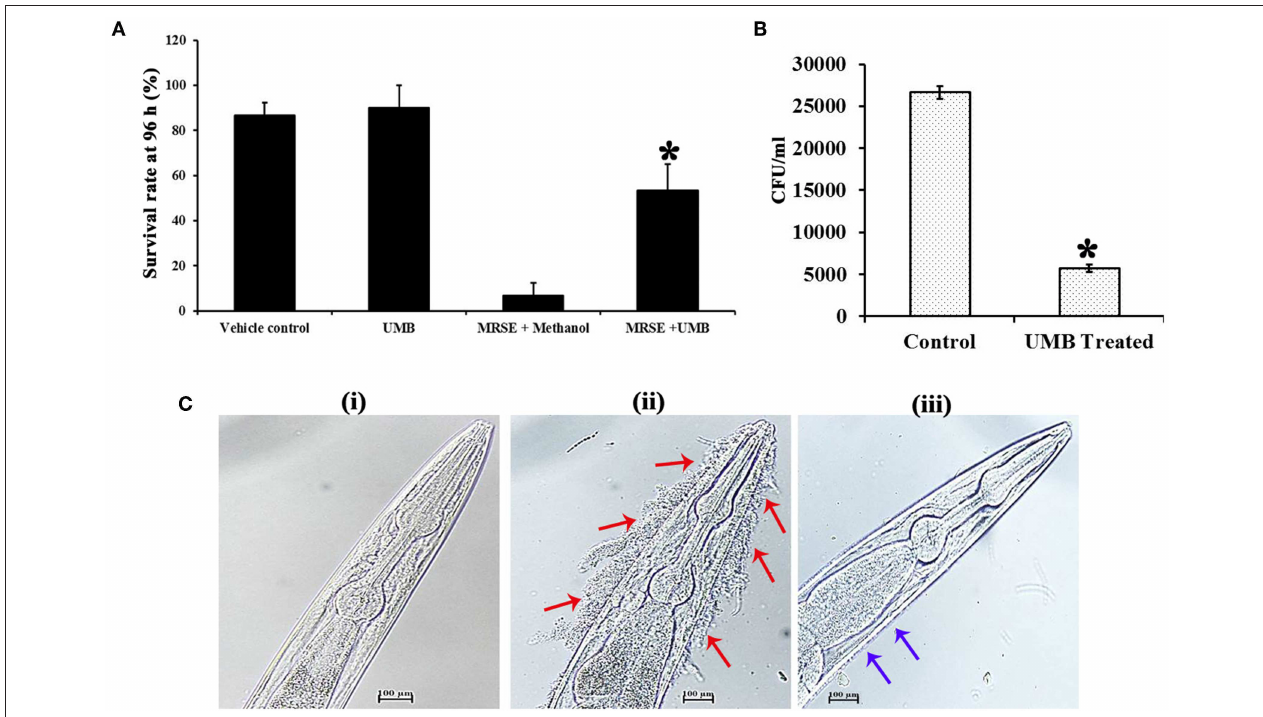
FIGURE 9 | Evaluation of cytotoxicity and in vivo efficacy of UMB using nematode model C. elegans. (A) The survivability of E. coli OP50 fed C. elegans was increased upon UMB treatment, attesting the innocuous nature as well as health benefit of UMB. The increased survivability of MRSE infected worms in the presence of UMB signifies the antivirulence activity of UMB. (B) Bar chart depicting the decreased bacterial load in UMB treated worms than that of untreated control worms, confirming the antibiofilm efficacy of UMB. (C) LM images (400X, scale bar- − 100 µ m) of anterior part of C. elegans grown in the presence of (i) E. coli OP50, (ii) MRSE, and (iii) MRSE + UMB (at 500 µ g/ml). The adherence of UMB treated MRSE (indicated by blue arrows) to C. elegans cuticle is considerably reduced than untreated MRSE (indicated by red arrows), endorsing the antiadherence property of UMB. Error bars depict standard deviation. *Statistical significance between control and treated samples from three independent experiments ( p <